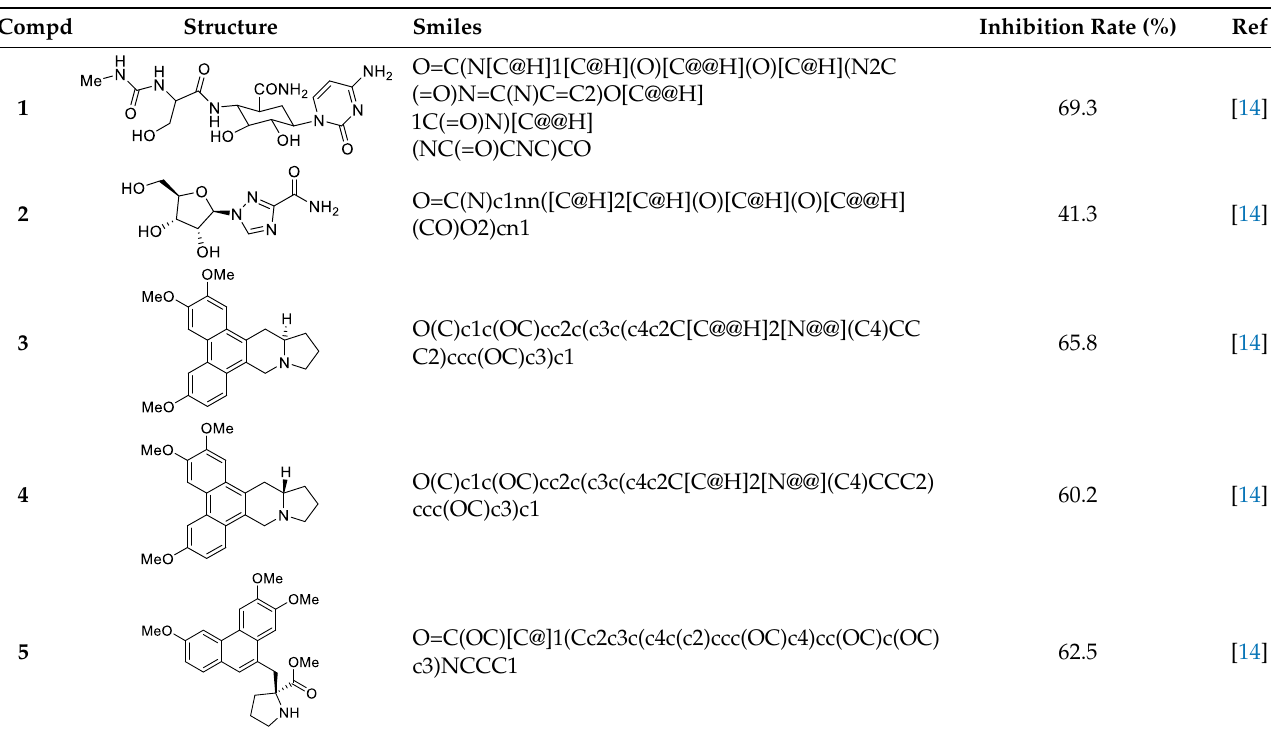
Table 1. The inhibition rate (%) of the antofine analogues 1 – 43 against TMV and their smiles. Compd Structure